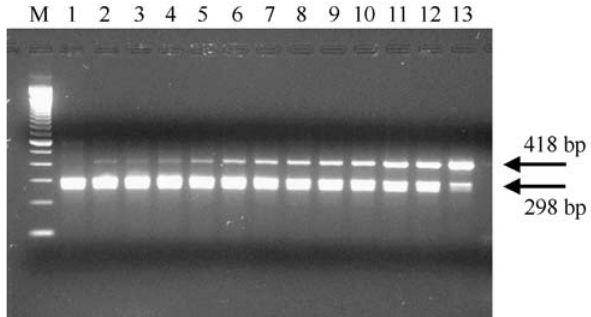
Figure 7 - GH cDNA and the unspecific competitor amplicons separated by 1.5% agarose gel electrophoresis Lane M: 100-bp DNA molecular weight markers; Lanes 1-13: Competitive RT-PCR products using 100 ng, 10 ng, 8 ng, 6 ng, 4 ng, 2 ng, 1 ng, 0.8 ng, 0.6 ng, 0.4 ng, 0.2 ng, 0.1 ng, and 0.01 ng of 298-bp purified DNA as competitor template, and 10 ng of total RNA. The 418-bp band represents the GH mRNA, and the 298-bp band the competitor obtained by low-stringency PCR.